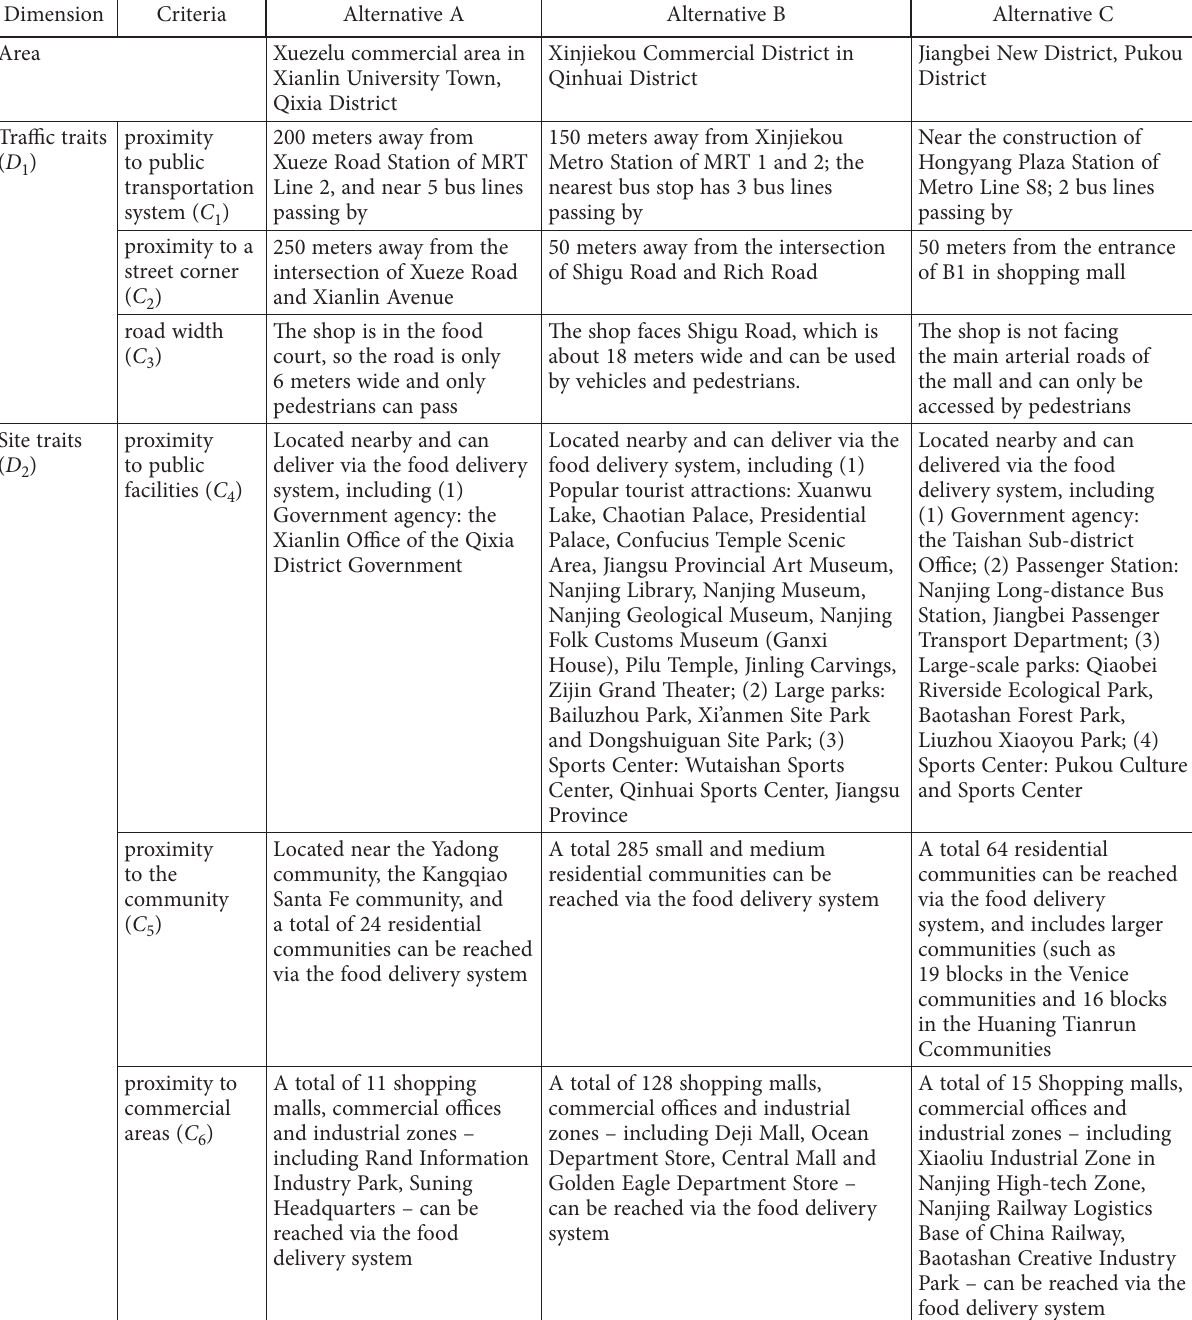
Table 2. Three alternatives in Nanjing for performance